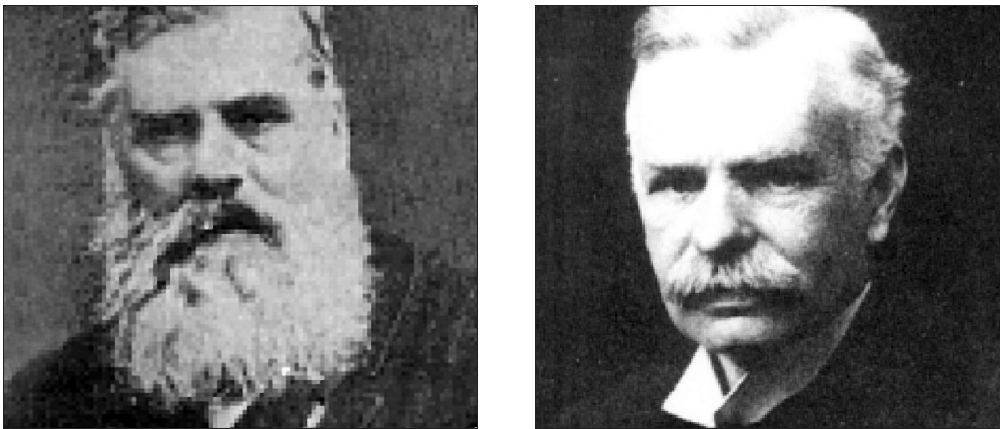
Fig. 3. Oldham, father and son, were both geologists in India. Thomas Oldham (left) compiled the first cata- logue of Indian earthquakes. Richard (right) made definitive studies of individual earthquakes (1819, 1869, 1881 and 1897) in addition to identifying for the first time p -waves and s -waves, and the core of the